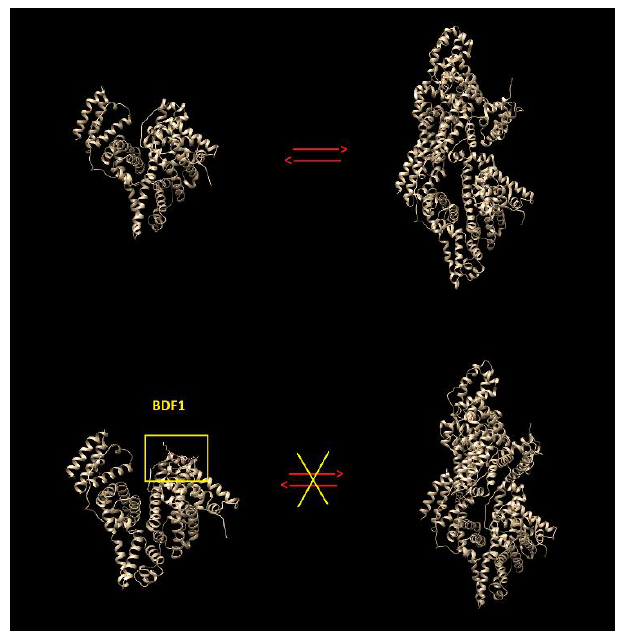
Figure 6. Schematic representation of the monomer—dimer equilibrium of BSA in both its unliganded form and complex with BDF1. Note how BDF1 binds to BSA onto its surface in a region needed for BSA dimerization.